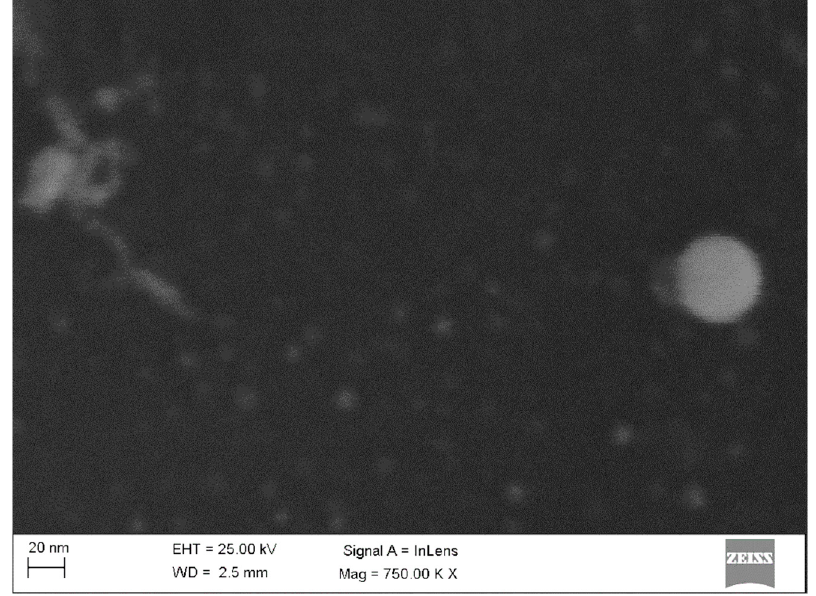
Figure 12. Nanosized Au particles inside the irradiation area .